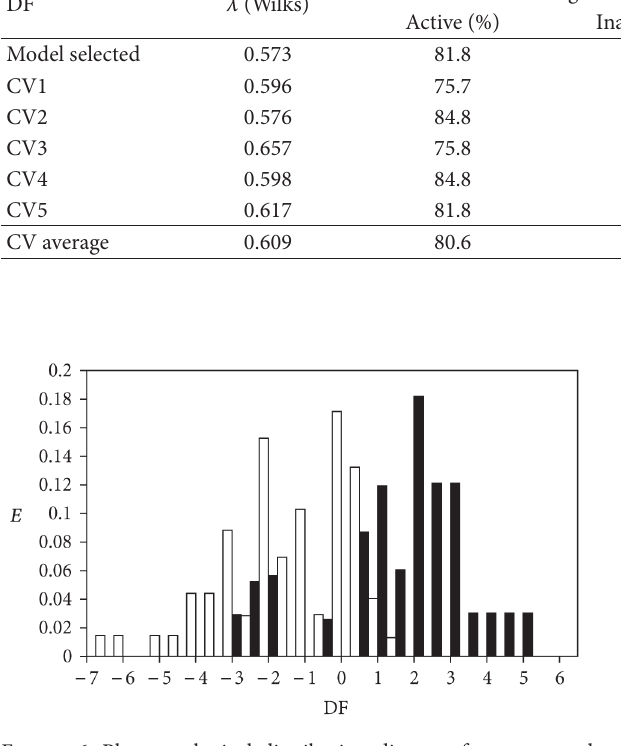
F 6: Pharmacological distribution diagram for compounds causing dyspnea as a side effect. e plot represents expectancy ( E ) versus DF function (the black and white bars are the active and inactive compounds,